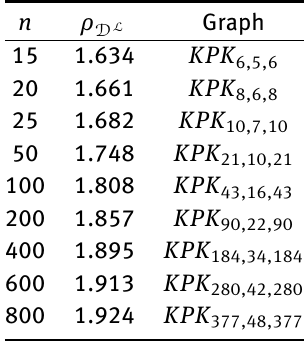
Table 2: Evidence that maximum ρ D L approaches 2 as n becomes large, data from Sage